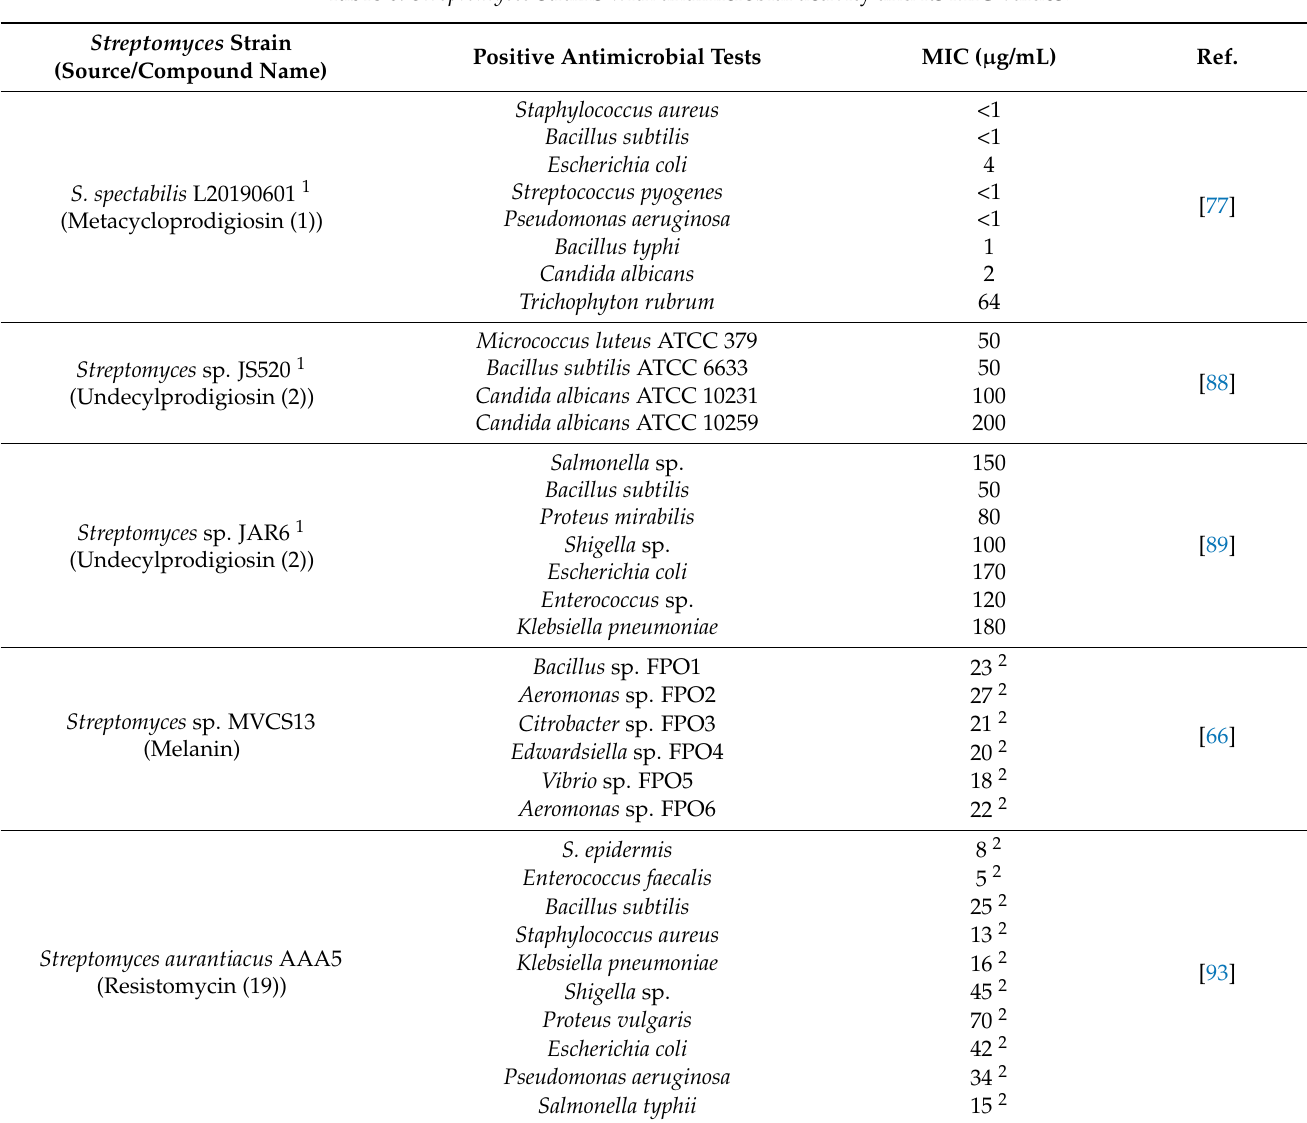
Table 6. Streptomyces strains with antimicrobial activity and its MIC